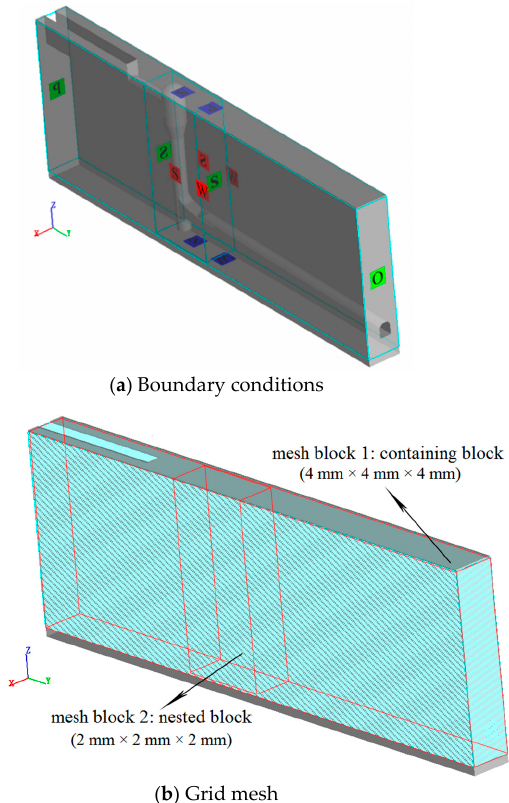
Figure 3. Boundary conditions and grid mesh in the numerical